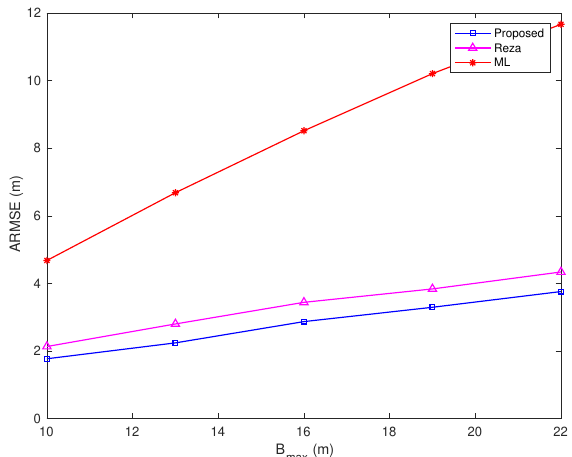
Figure 8. Average root mean-square errors (ARMSEs) vs. NLOS error bound B max ( σ = 0.5 m, and the percentage of NLOS links equals 50%).